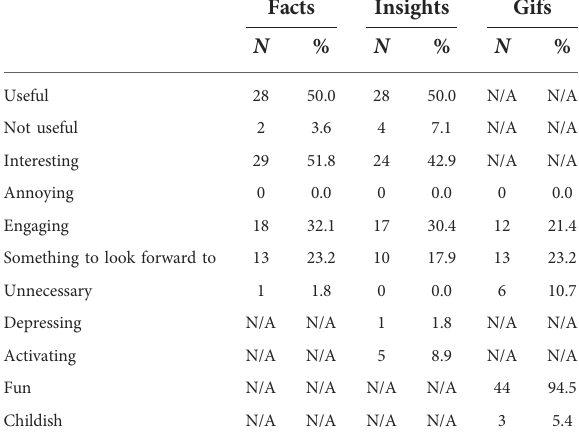
TABLE 5 Ratings of insights, facts, and gifs provided by low-incentive